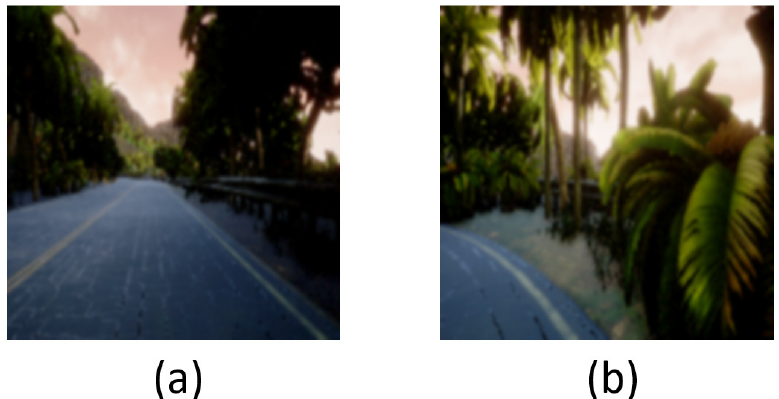
Figure 5. ( a ) An example of an image including a higher percentage of the road area; ( b ) an example of an image including a lower percentage of the road area.